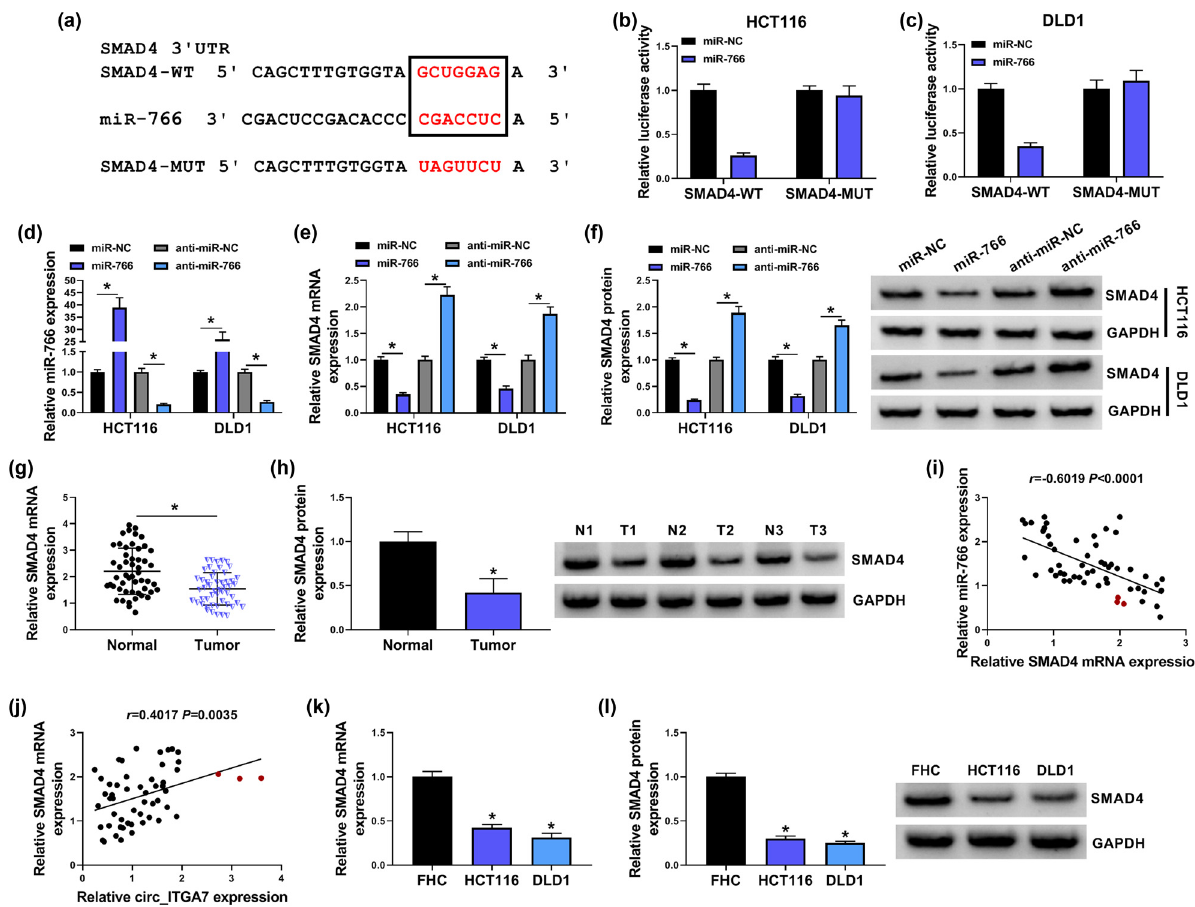
Figure 5: SMAD4 is a target of miR - 766. ( a ) Schematic diagram representing the predicted binding sites for miR - 766 in SMAD4. ( b and c ) Dual - luciferase activity assay for the detection of the relative luciferase activity of wild and mutated SMAD4 reporter after miR - 766 up - regulation in HCT116 and DLD1 cells. ( d – f ) HCT116 and DLD1 cells were transfected with miR - 766 mimic, inhibitor, or their negative control. ( d ) qRT - PCR analysis ofmiR - 766expressioninHCT116andDLD1cells. ( eandf ) qRT - PCRandwesternblotanalysisofSMAD4levelsinHCT116andDLD1cells. ( g ) qRT - PCR of SMAD4 mRNA levels in CRC tissues and matched normal tissues. ( h ) Western blot analysis of SMAD4 protein levels in three pairs of CRC tissues ( T1 – T3 ) and matchednormaltissues ( N1 – N3 ) . ( iandj ) Pearson ’ scorrelationcoe ffi cient analysis for thecorrelationbetweenSMAD4andmiR - 766